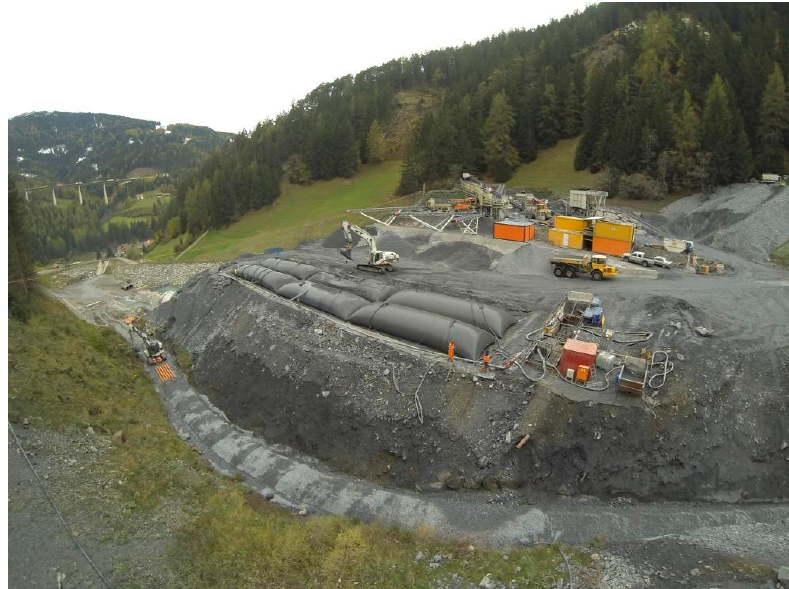
Figure 8. Processing plant and aggregate production near the tunnel portal at the access tunnel Wolf.